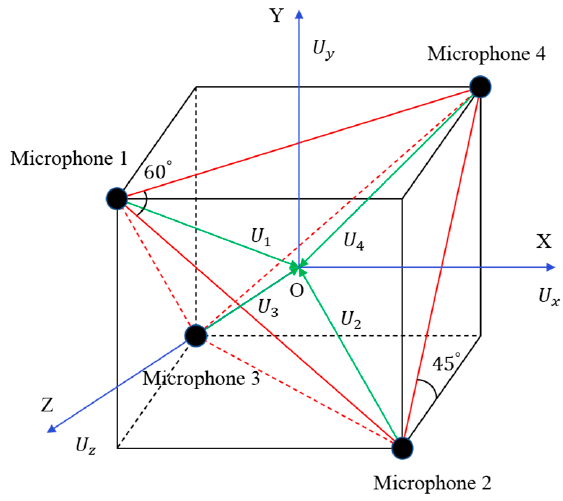
Figure 1. The schematic of the three-dimensional sound intensity probe. In Figure 1, the diagonal length of the cube surface is d 1 , and the distance from each √ √ vertex to the center O is a , a = ( 3/2 2 ) d 1 . Among the 4 microphones, the connection of → → → U Z ( t ) are the particle U x ( t ) , U y ( t ) , and any 3 microphones can form an equilateral triangle. velocities in the X, Y, and Z axes of the three-dimensional coordinate system, respectively. Supposing the sound pressure measured by the four microphones is p 1 ( t ) , p 2 ( t ) , p 3 ( t ) , and p 4 ( t ) and their Fourier transform is P 1 ( ω ) , P 2 ( ω ) , P 3 ( ω ) , and P 4 ( ω ) , abbreviated as P 1 , P 2 , P 3 , and P 4 . Then, the sound pressure P O at the center point O is approximately equal to the average of the sound pressure measured by the four microphones, namely: